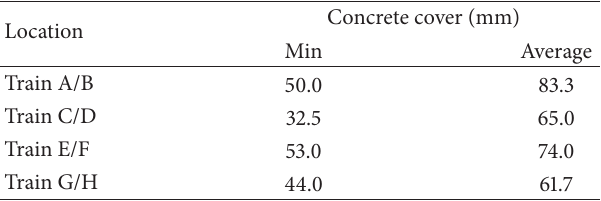
Table 8: Concrete cover